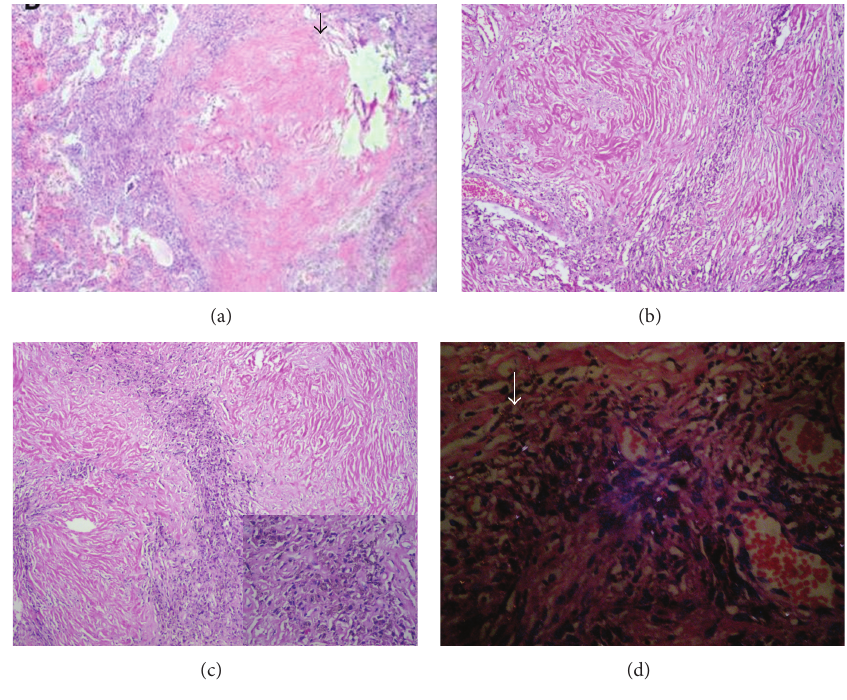
Figure 2: (a) Lung parenchyma showed collagenous nodules (arrow) (H&E × 100), (b) silicotic nodule: central zone of whorls of hyalinised fibrous tissue, midzone of concentrically arranged collagen fibres, and outer zone of randomly orientated collagen fibres and inflammatory cells (H&E × 200), (c) periphery of the nodules with dust laden macrophages and lymphoid cells (H&E × 200), inset: dust laden macrophages (H&E × 400), and (d) polarized light microscopy, white spots which represent silica crystals (white